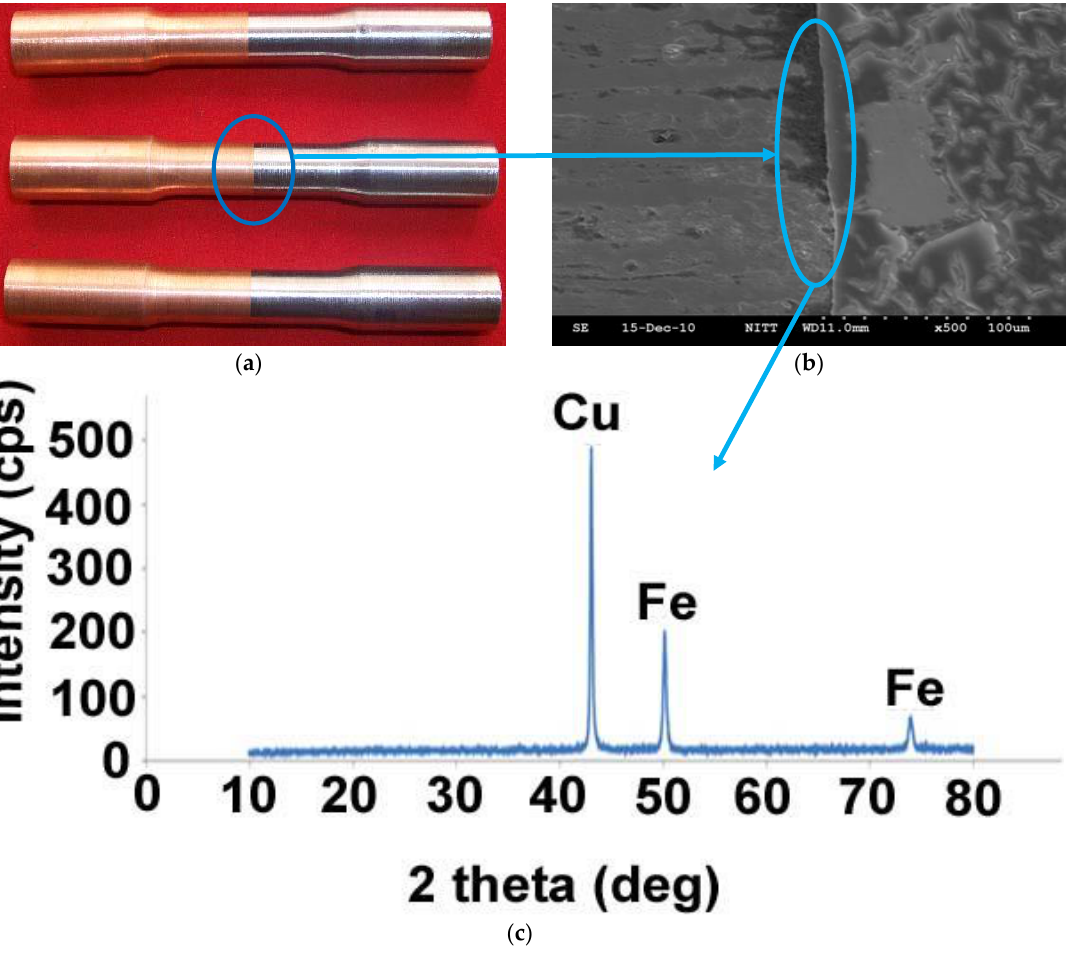
Figure 5. ( a , b ) SEM micrograph of weld interface; ( c ) X-ray diffraction analysis at the weld